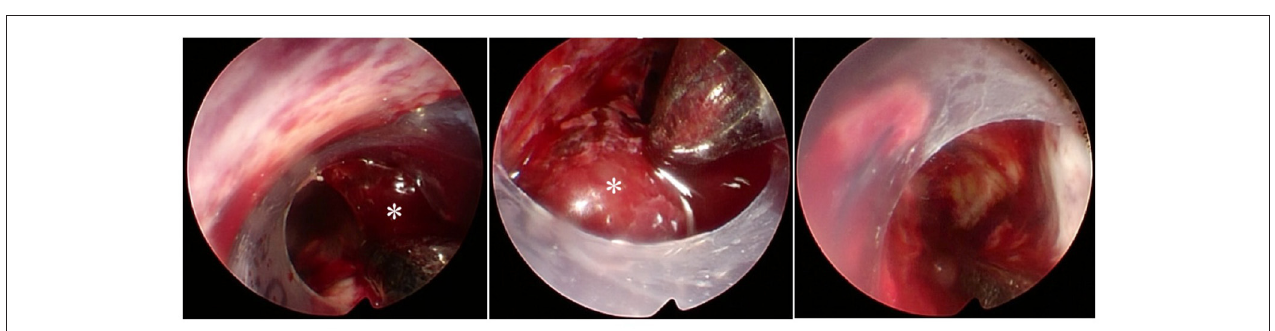
at 180 days ( P = 0.01 and 0.003, respectively). Two